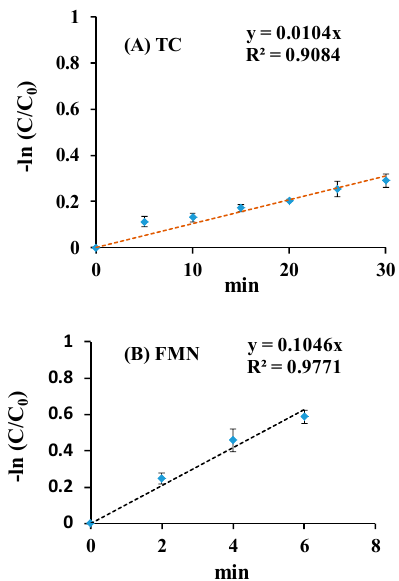
Figure 9. The k appa. of ( A ) TC and ( B ) FMN treated with blue light irradiation at 20 W / m 2 . Microorganisms 2019 , 7 , x FOR PEER REVIEW